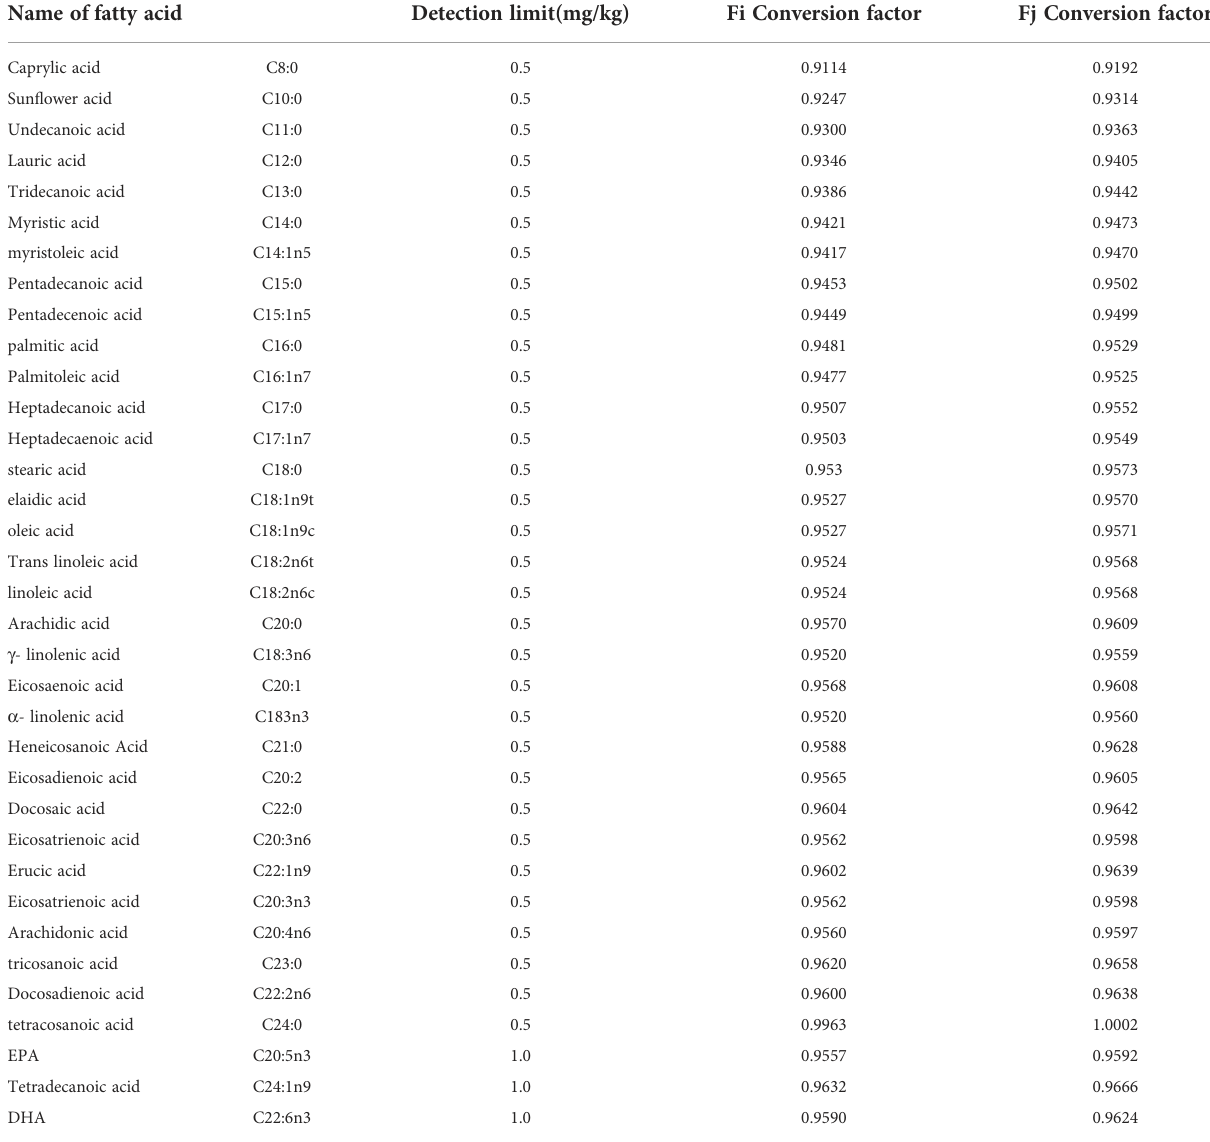
TABLE 2 Fatty acid types and detection limits and conversion coef fi cients of fatty acid methyl esters or fatty acid triglycerides to fatty